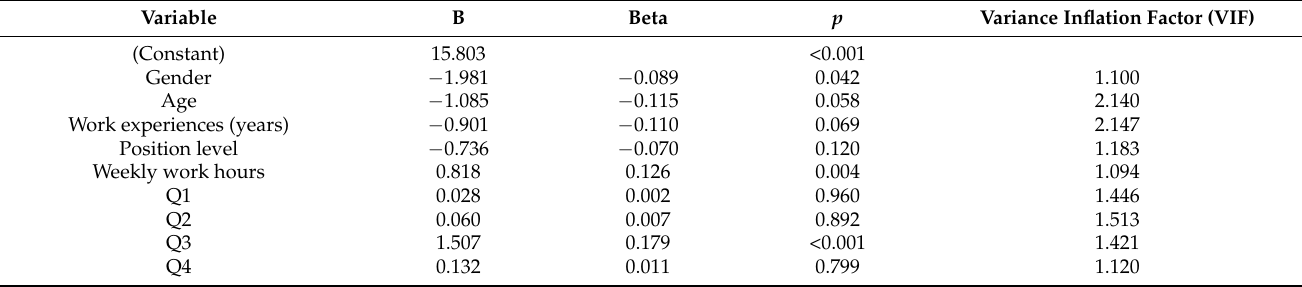
Table 10. Results of regression analysis of